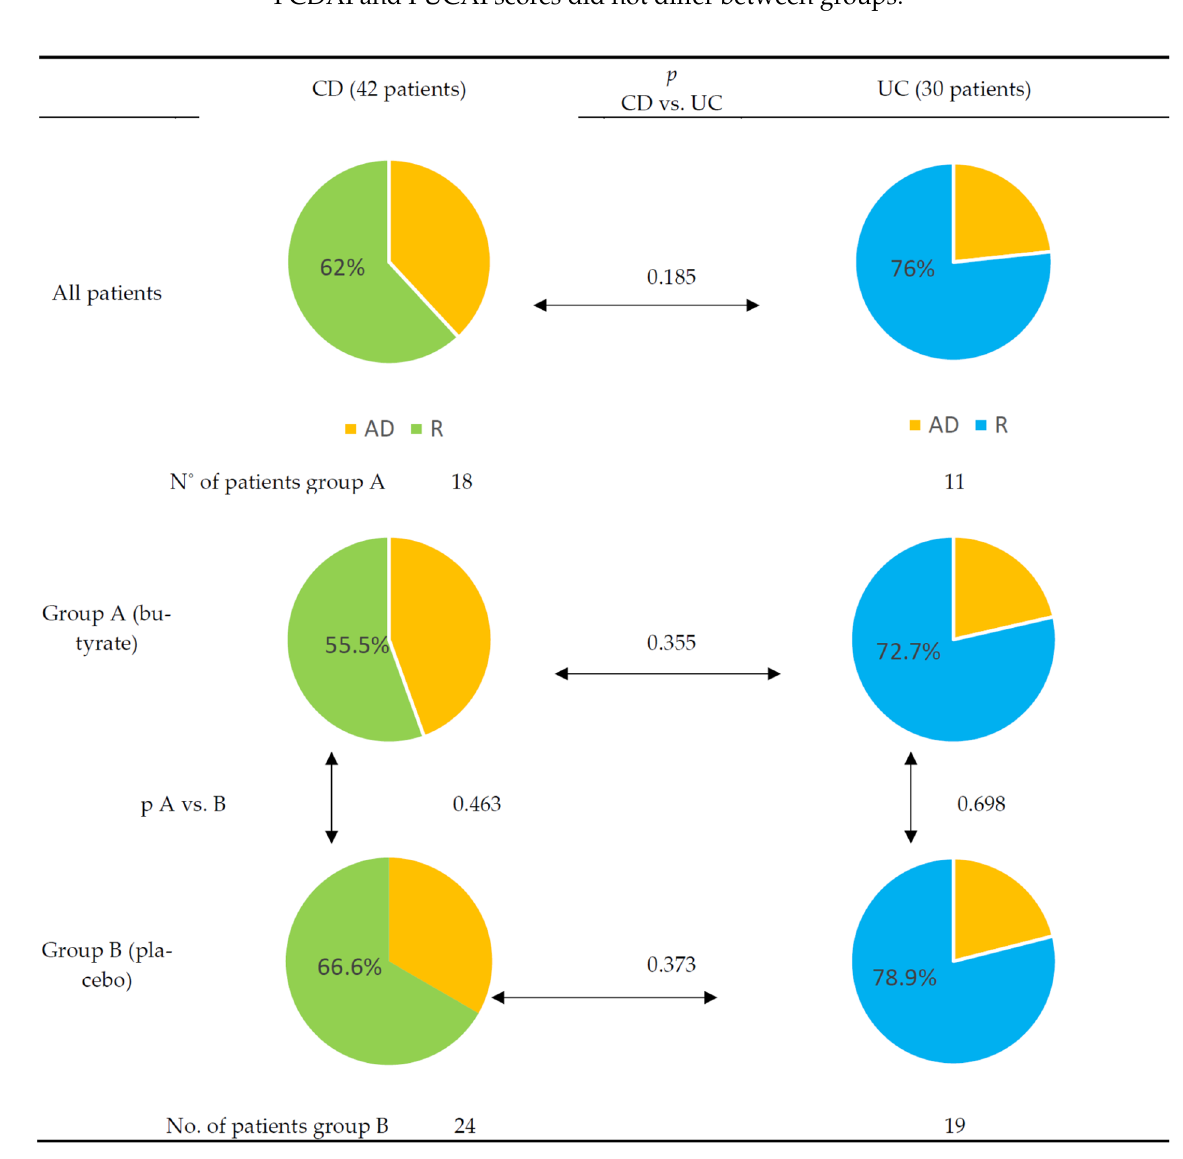
Figure 2. Differences between Crohn’s disease and ulcerative colitis cohorts after 12 weeks of treatment. treatment. Yellow—active disease (AD). Green—remission (R) in Crohn’s disease (CD). Blue— Yellow—active disease (AD). Green—remission (R) in Crohn’s disease (CD). Blue—remission (R) in ulcerative colitis (UC). remission (R) in ulcerative colitis